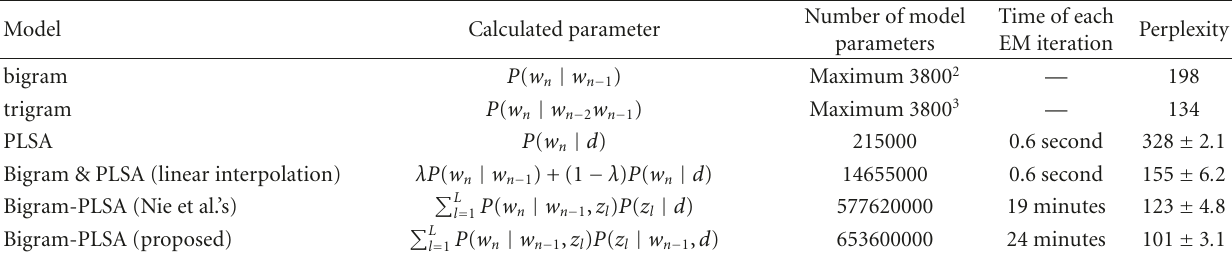
Table 2: Perplexities, number of parameters, and the computation cost of the bigram-PLSA model and other language models. Model